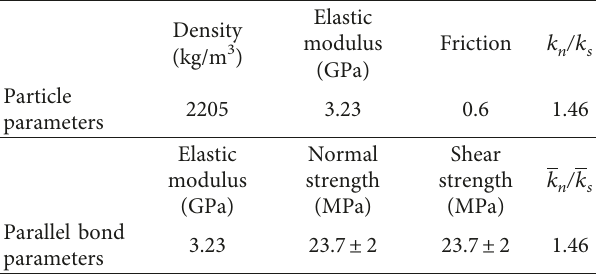
Table 1: Input microscopic parameters of the numerical model.